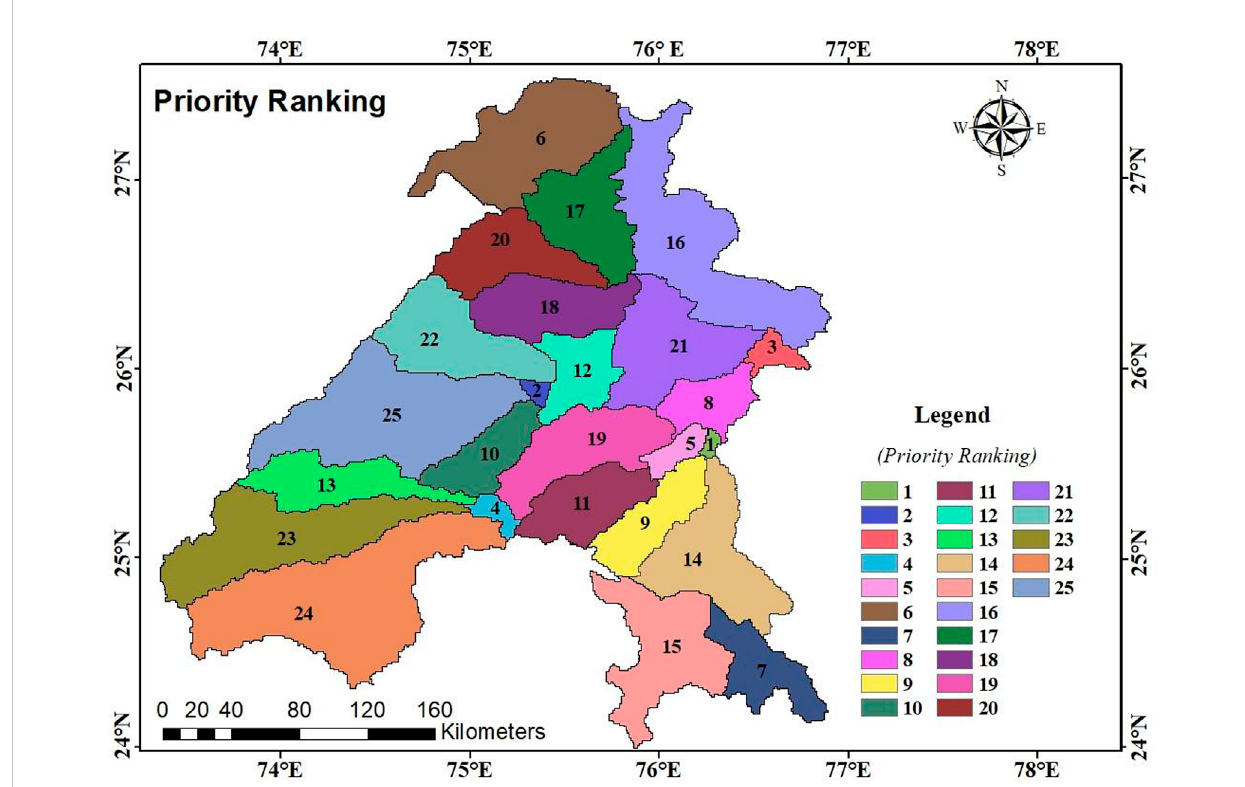
Priority ranking of the watershed in relation to the severity of soil loss from their